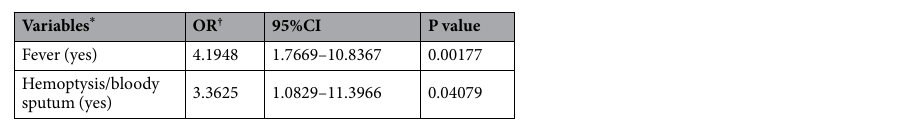
Table 1. The odds ratios of variables associated with Lineage 2 in Uygur patients. † Denotes adjusted OR in logistic